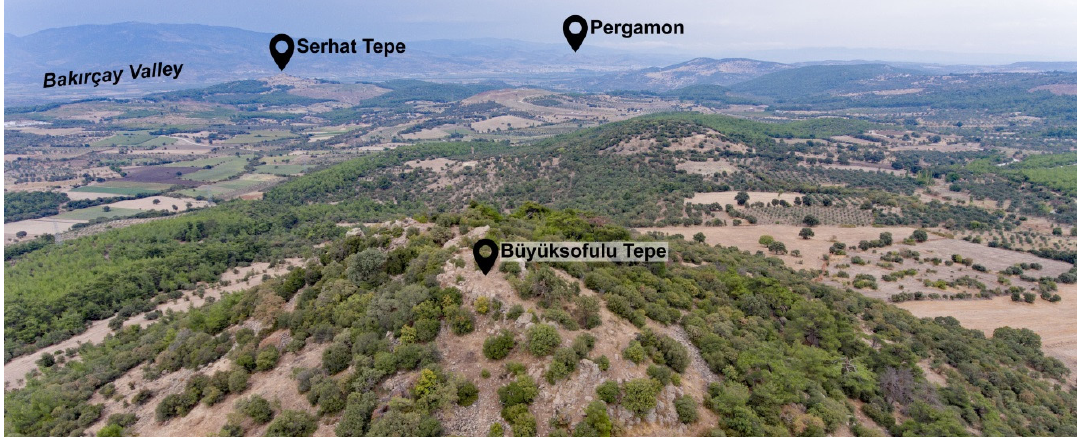
Figure 22. View from the fortress on Büyüksofulu Tepe to the north. Route J1.2 ran from east (right) to west (left) into the Bak ı rçay valley passing between Büyüksofulu Tepe and Serhat Tepe.